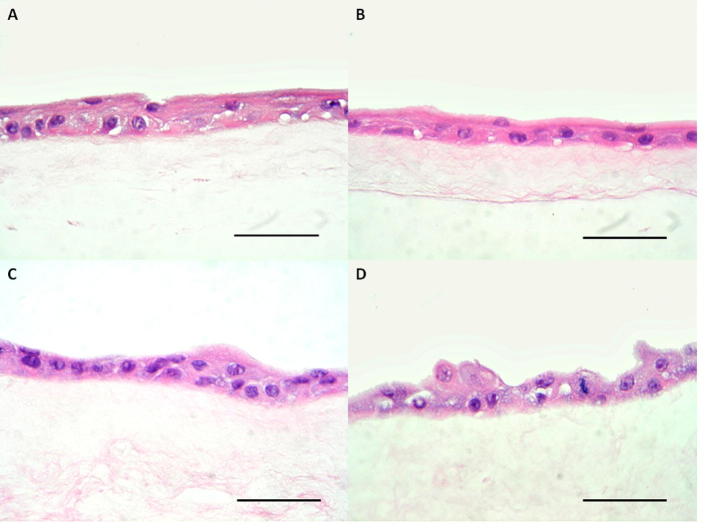
Haematoxylin and eosin stained histological images showing cell morphology of limbal explant cultures on (A) fresh HAM, (B) NaOH decellularised HAM, (C) non-gamma irradiated SDS decellularised HAM, and (D) gamma-irradiated SDS decellularised HAM. Scale bars are 100 µm.